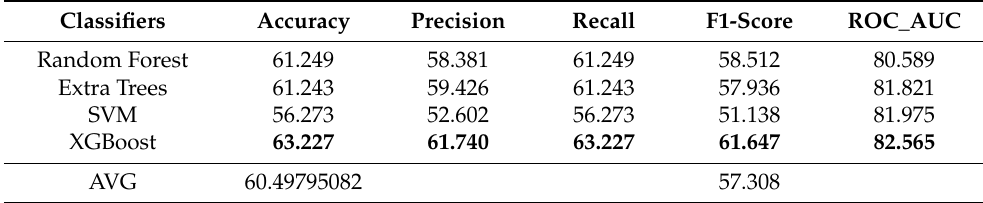
Table 2. RNA Raw Experimental